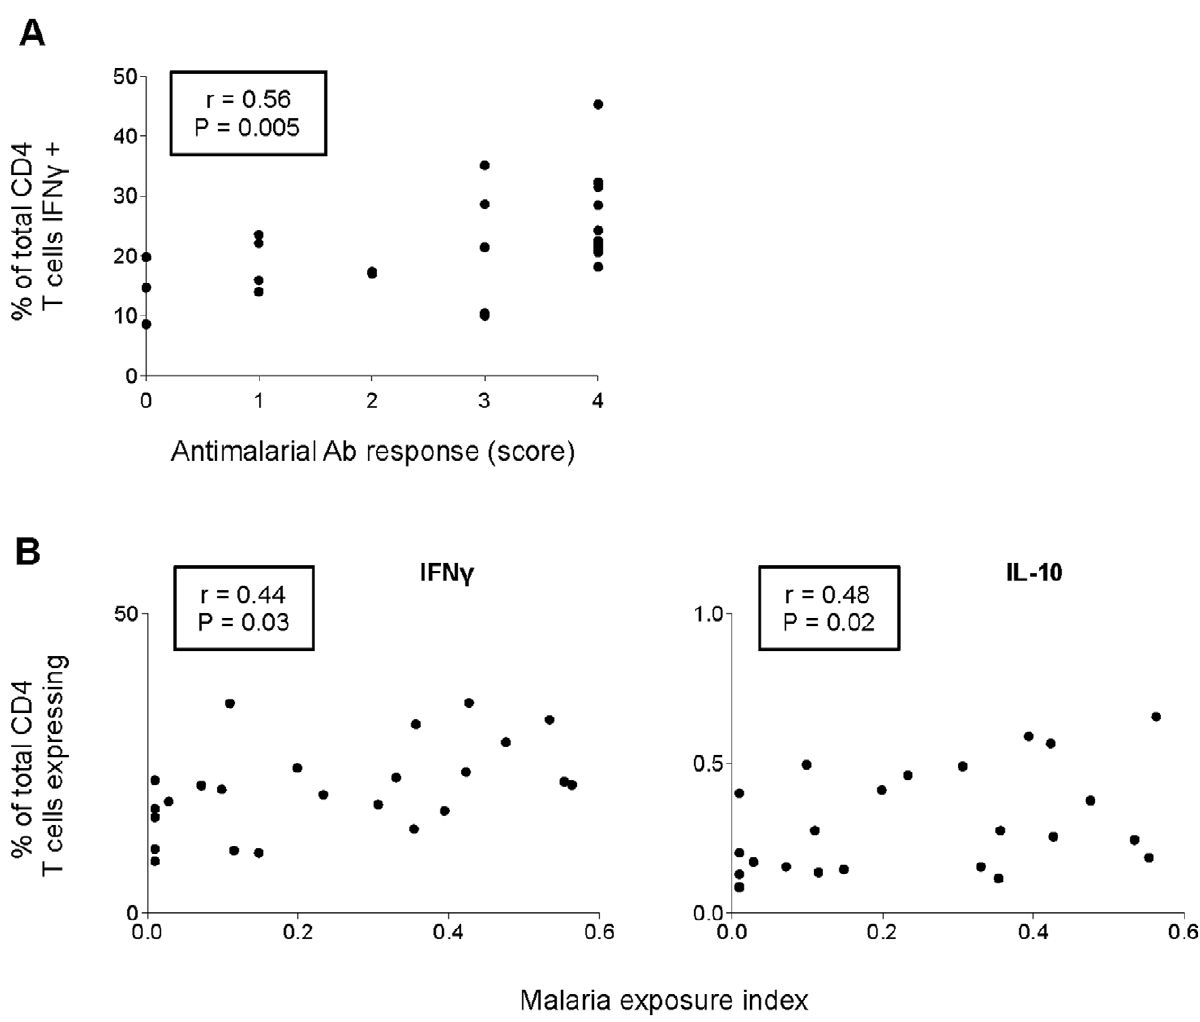
Figure 6. Total frequency of IFN c and/or IL-10 expressing CD4 T cells correlates with malaria exposure. The percentage of total CD4 T cells positive for either IFN c or IL-10 is plotted against either antimalarial Ab response, expressed by the number of Ag for which the Ab reactivity was defined as ‘‘high’’ levels (score between 0 and 4) (A), or malaria exposure indexes (B). Spearman’s correlation coefficients r and P -values are indicated for each